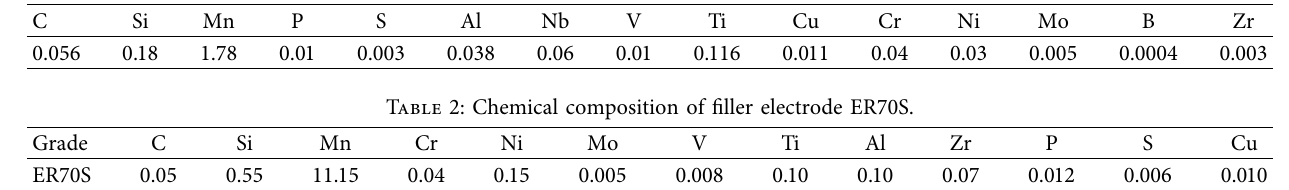
Table 1: Chemical composition of base metal (S700MC).